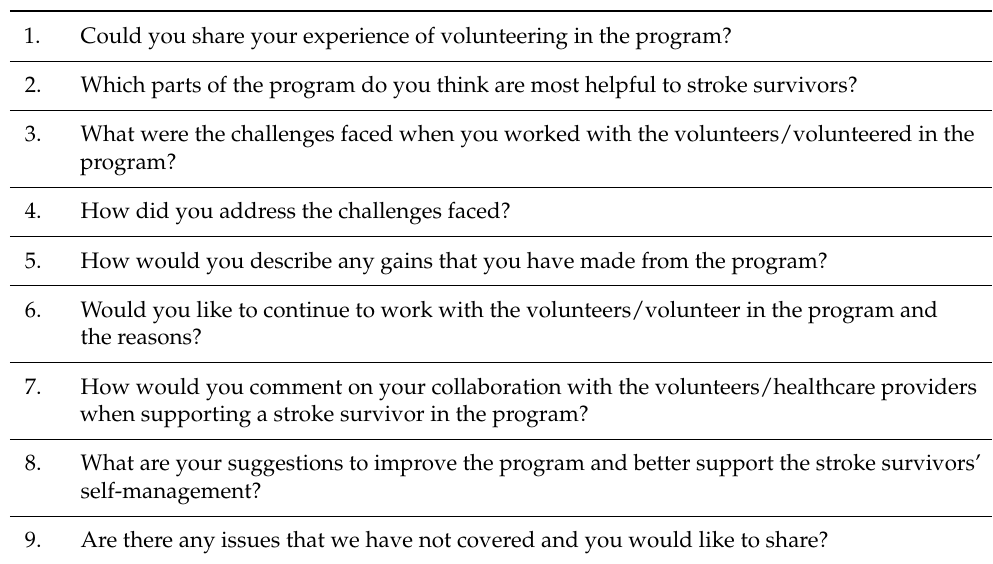
Table 2. Questions in the semi-structured interview